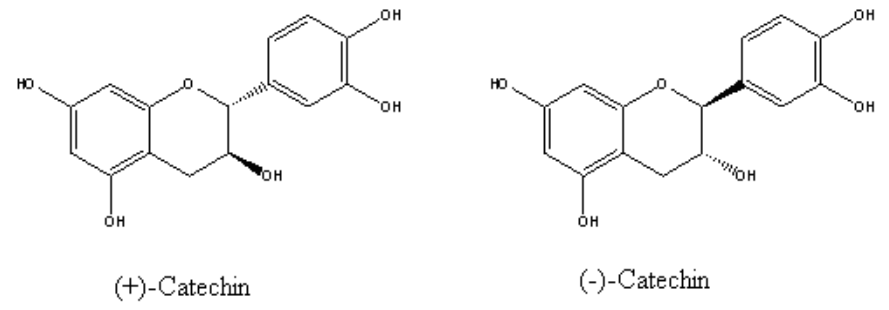
Figure 9. Structures of both enantiomers of catechin in C. maculosa root exudates